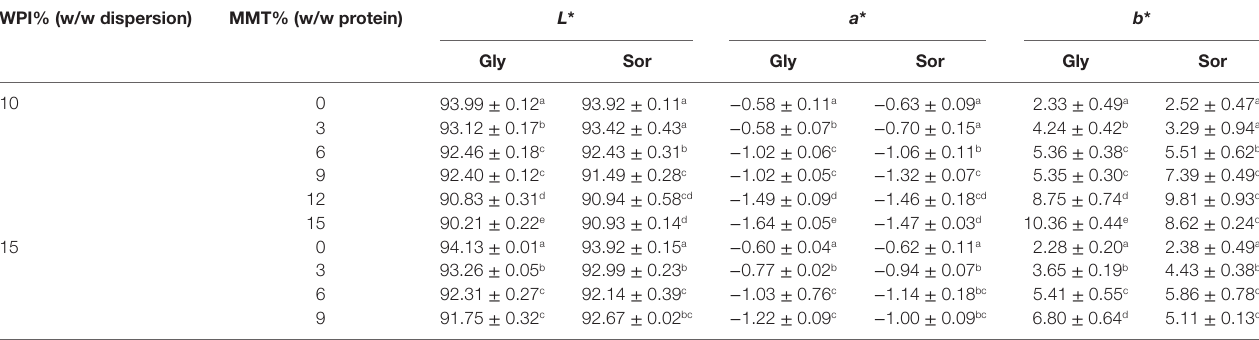
TaBle 6 | Results of the surface color testing for whey protein isolate (WPI)-based nanocomposite cast films with 10 and 15% (w/w) WPI and different montmorillonite (MMT)-nanoparticle loadings. WPi% (w/w